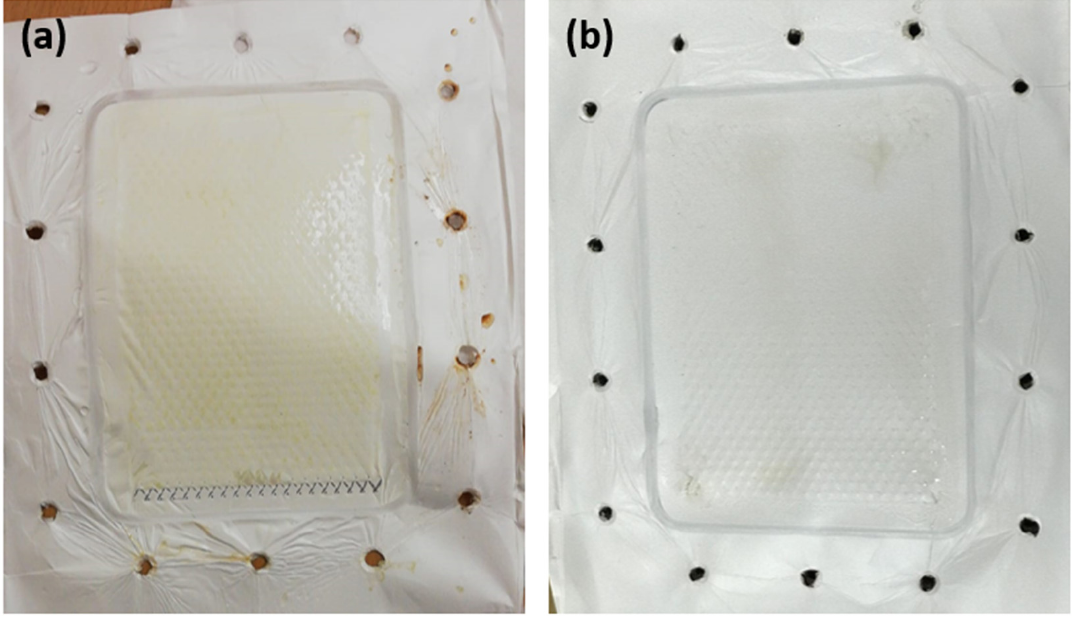
Figure 7. Images of PE membranes after 100 h of DCMD tests at concentrations of C1 and C2, ( a ) 75,500 and ( b ) 25,200 ppm, respectively.